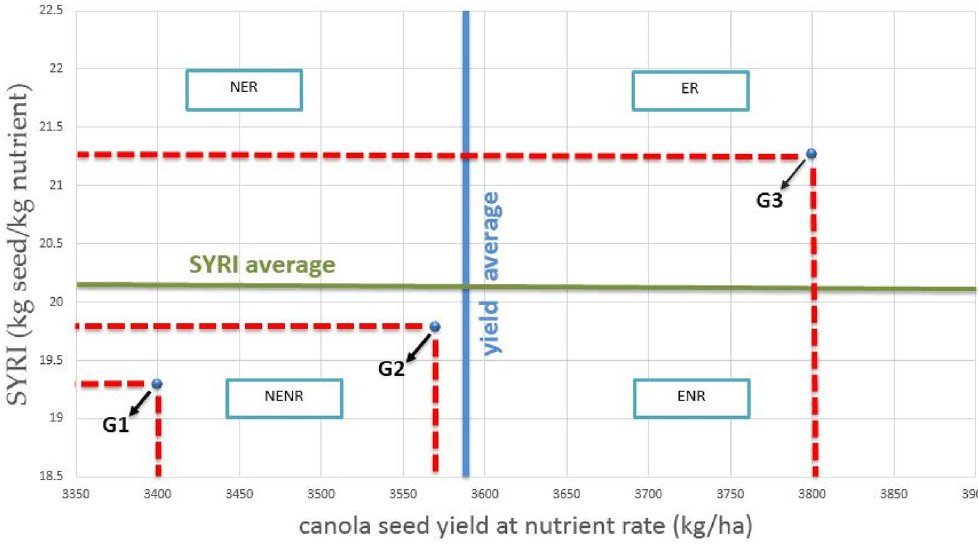
Figure 4. Seed yield response index (SYRI) of the tested Canola genotypes fertilized by nitrogen at a rate of 95 kg N ha −1 , 120 kg N ha −1 , 142 kg N ha −1 , 95 kg N ha −1 , + yeast extract, 120 kg N ha −1 , + yeast extract,